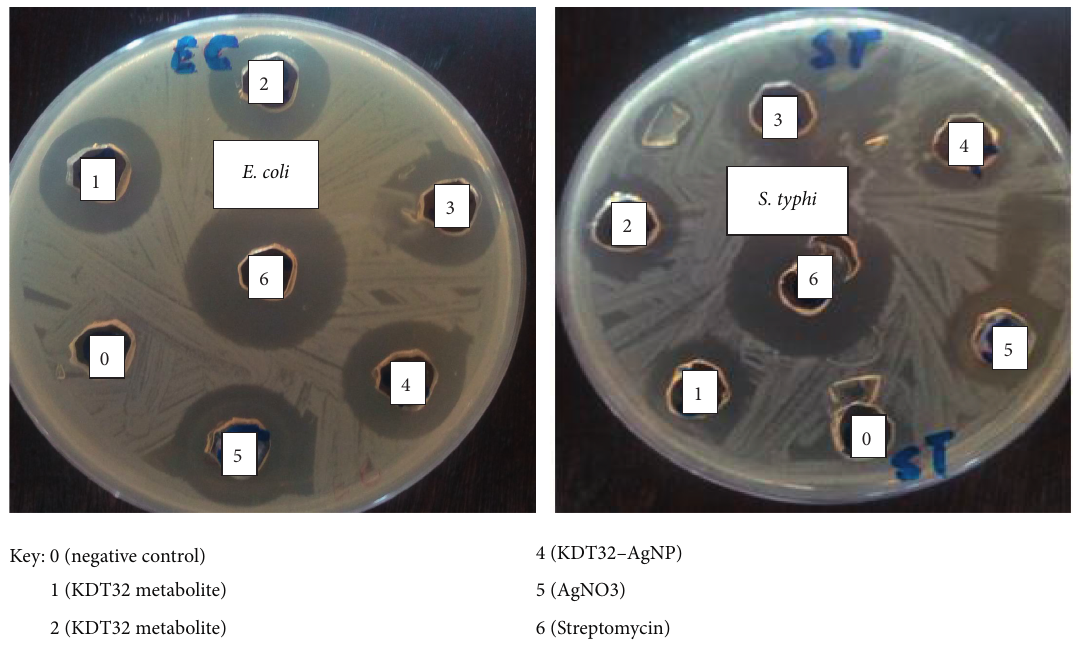
Figure 6: The bioactivity of silver nanoparticles against E. coli and S. typhi